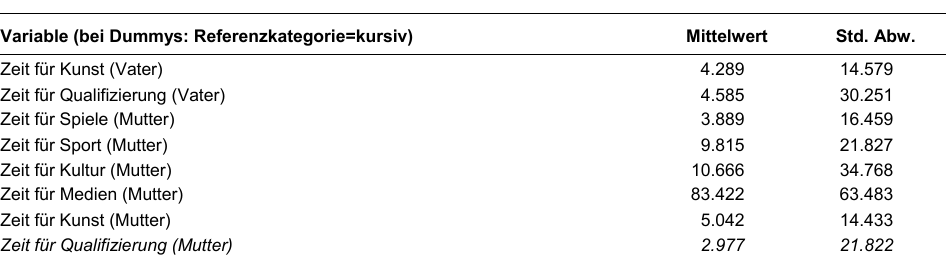
Für Tabelle A2 (Multivariate Analysen an allen Tagen: Detaillierte Ergebnisse/alle Kinder) Tabelle A3 (Multivariate Analysen an allen Tagen: Detaillierte Ergebnisse/10-13-jährige vs. 14-17-jährige